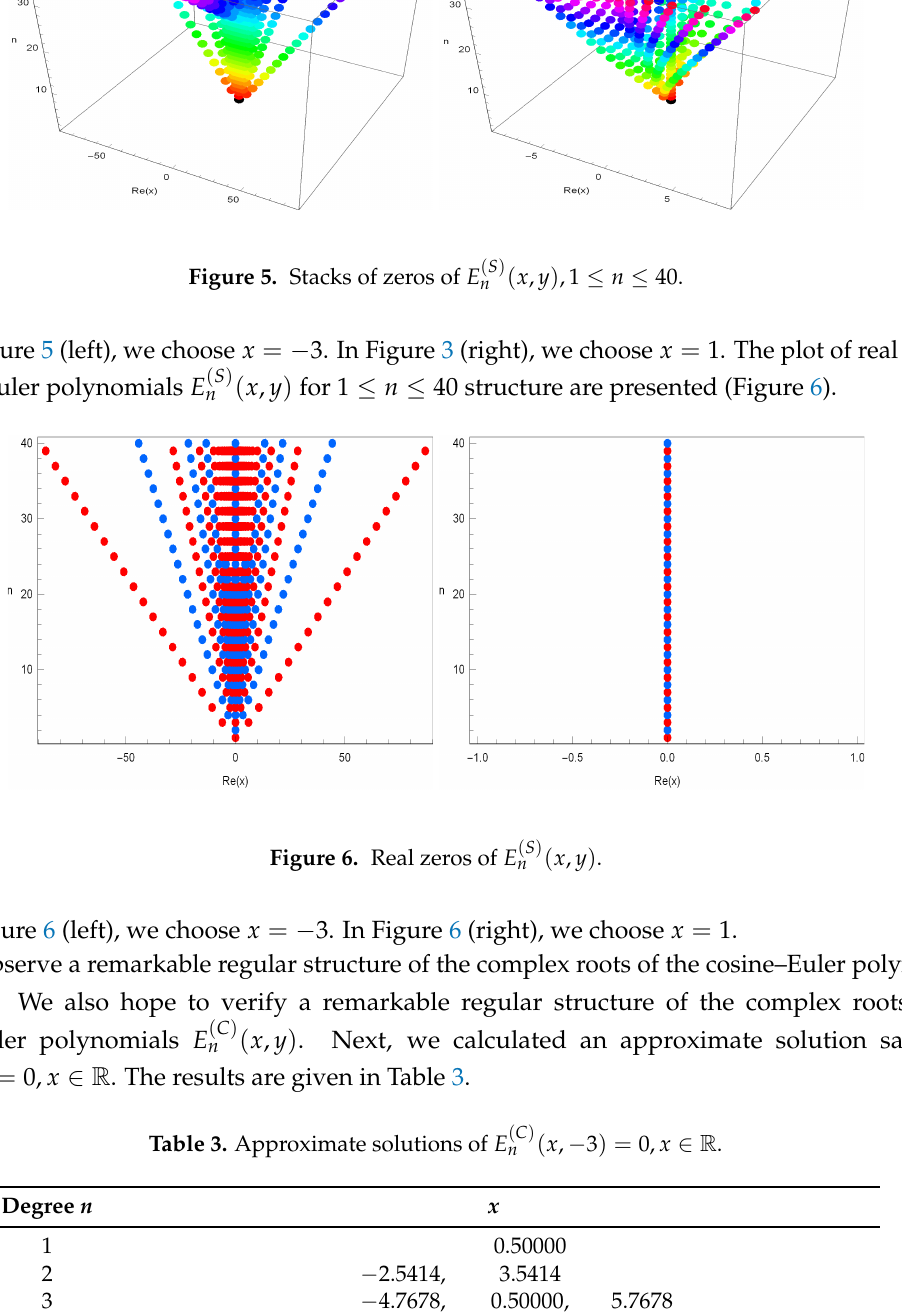
Figure 5. Stacks of zeros of E